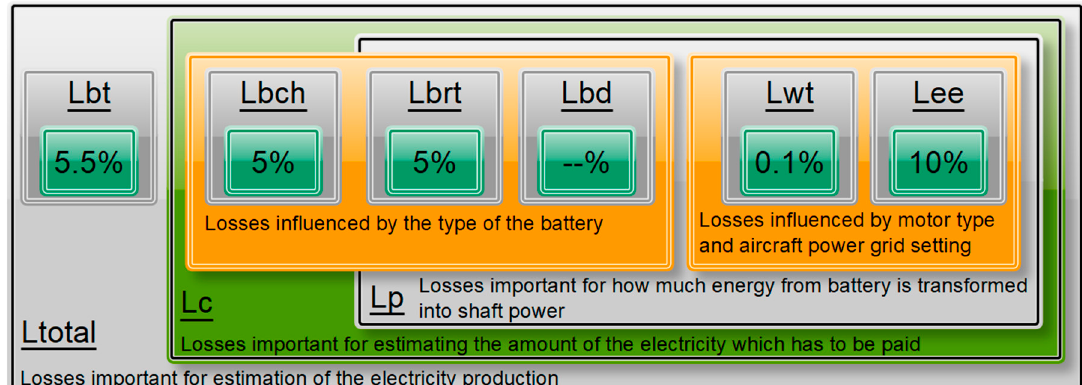
Figure 1. All-electric aircraft energy losses.